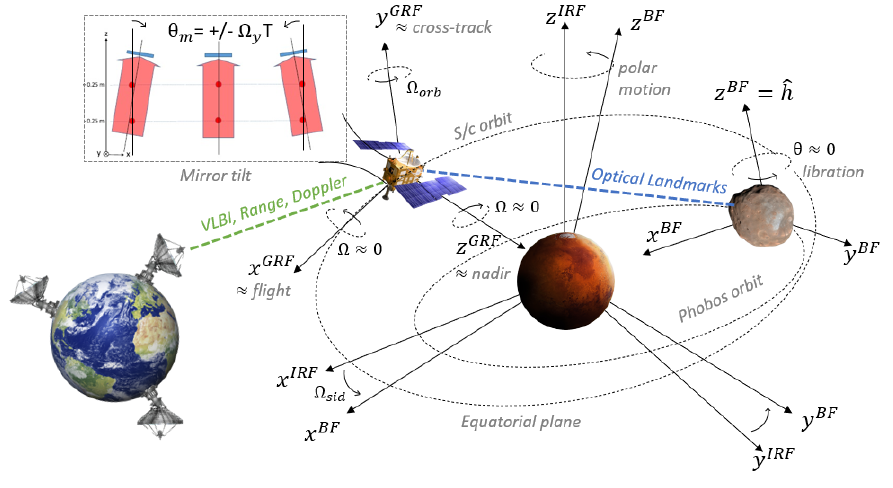
Figure 3. Illustrating the reference frames, rotations, observables and CAI rotation compensation.